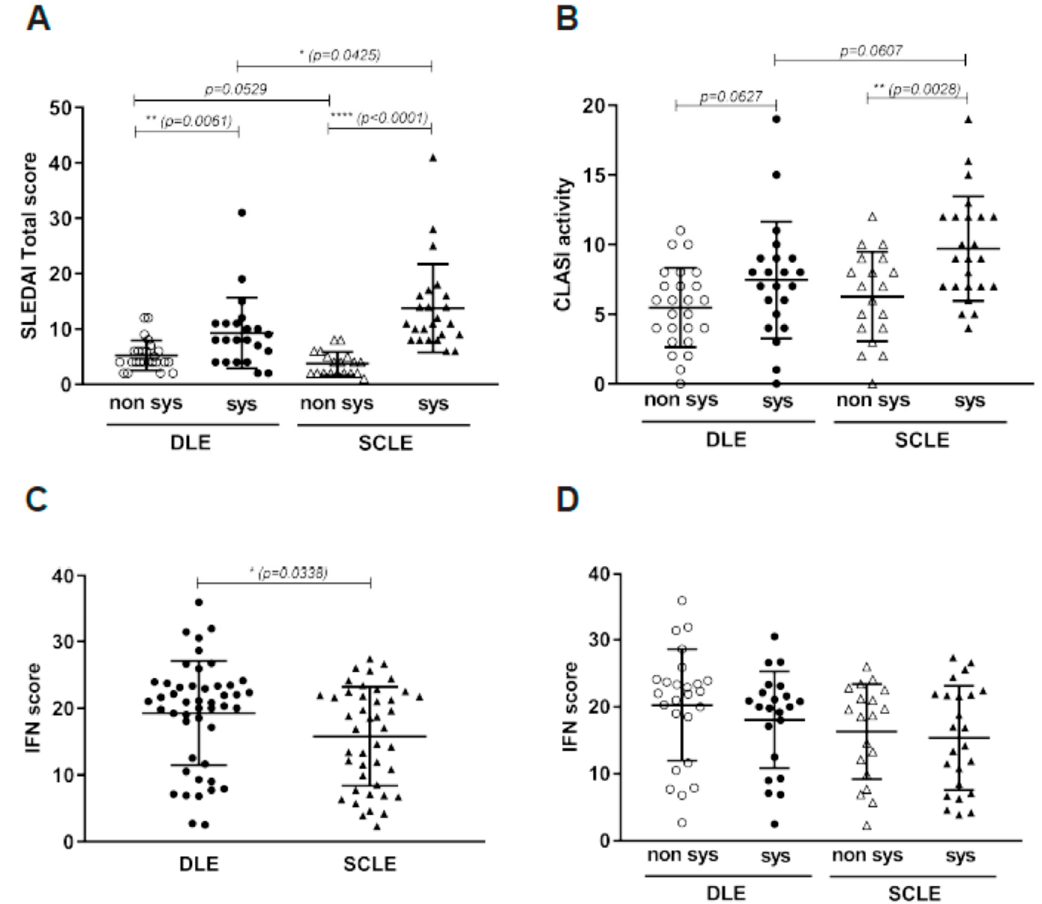
Figure 2. Disease activity in CLE lesions. ( A ). SLEDAI total score is higher is systemic compared to non-systemic disease in both DLE and SCLE lesions. ( B ). CLASI activity is higher in systemic compared to non-systemic disease in both DLE and SCLE. ( C ). IFN score was modestly but significantly lower in SCLE compared to DLE lesions. ( D ). IFN score did not show to be significantly different in systemic and non-systemic disease in patients showing DLE and SCLE lesions.